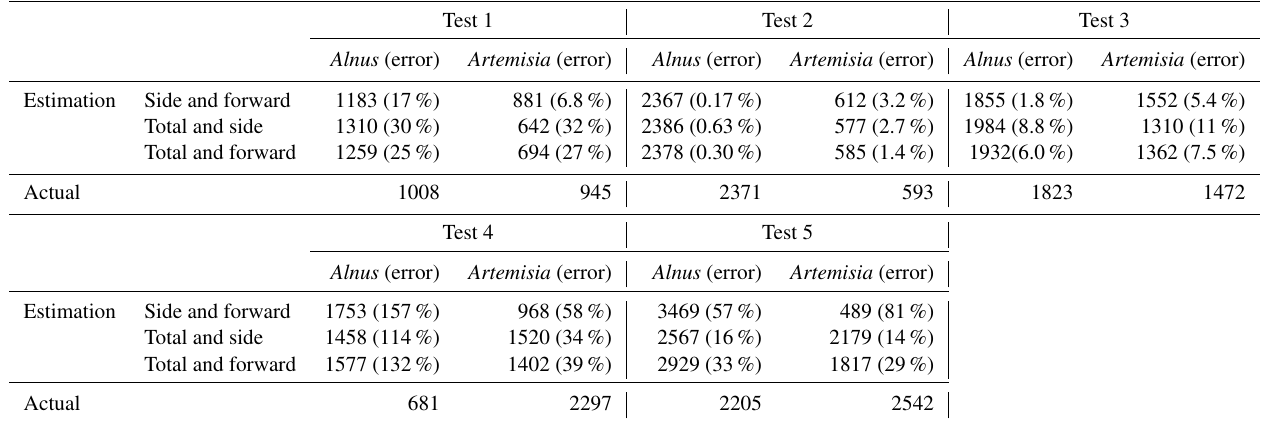
Table 3. Results of the estimation of the number of pollen grains of Alnus and Artemisia and the errors of each